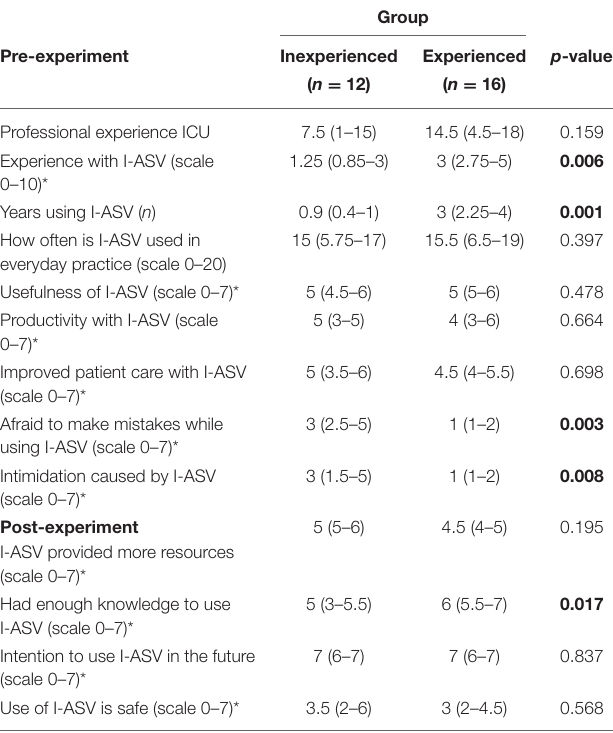
TABLE 2 | Pre- and post-experiment